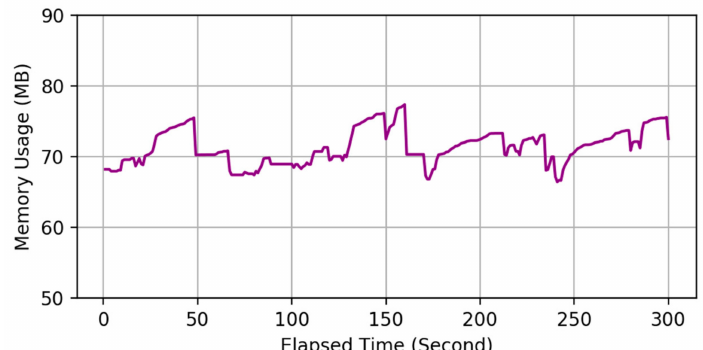
Figure 13. CPU utilization and memory usage of the CoVSCode server in a five-minute duration of a real-time collaboration